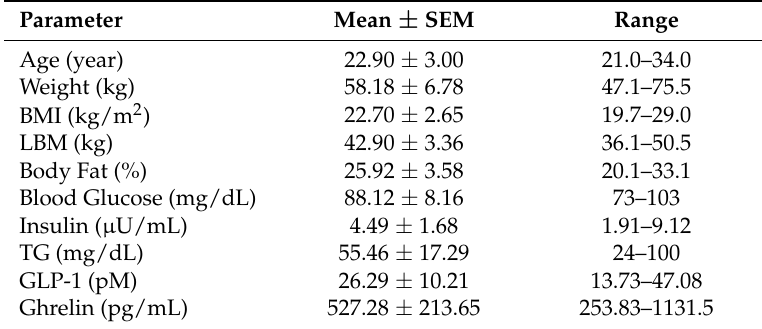
Table 2. Baseline characteristics of the study